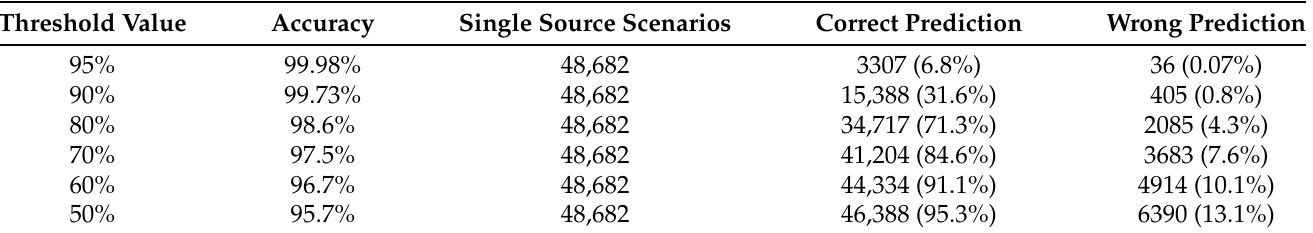
Table 1. Influence of threshold value on model accuracy for Net3 network (250 estimators, maximum depth 30, minimum samples for split 8). Percentage indicates number of predicted simulations based on total number of single source scenarios.